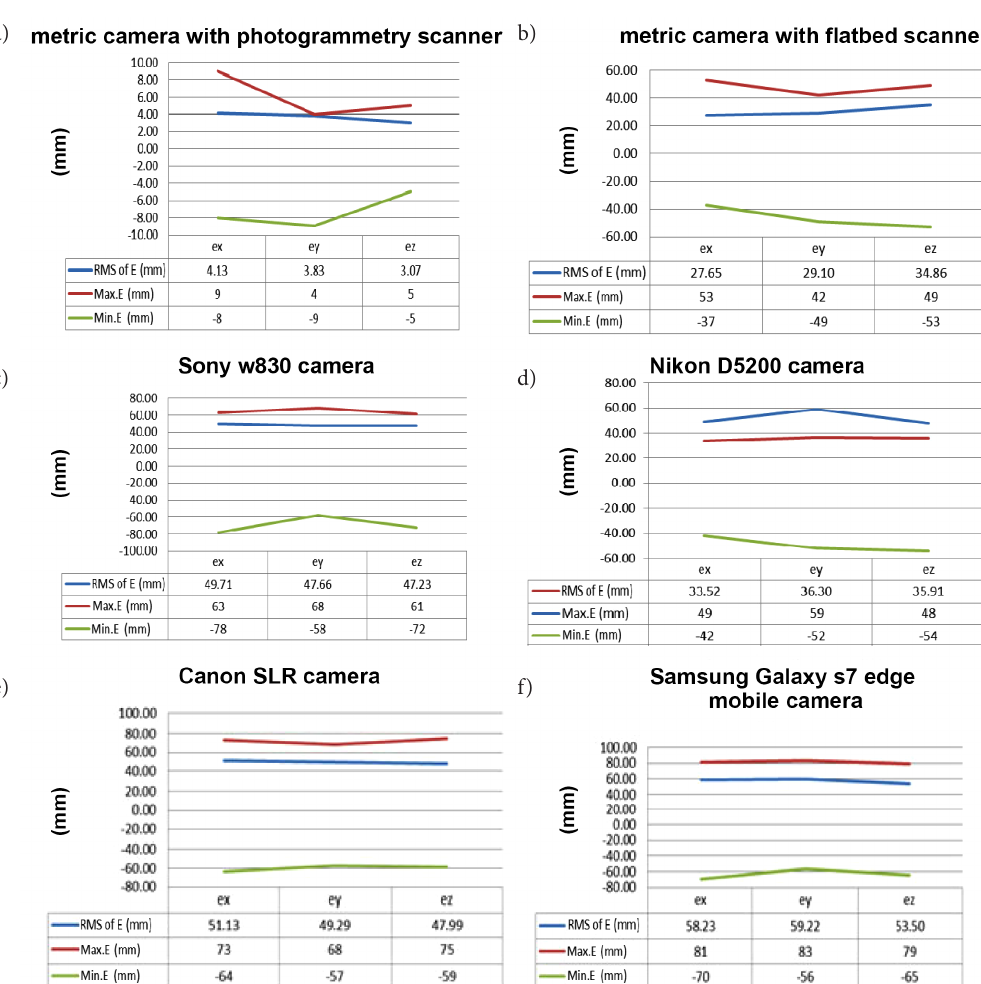
Figure 11. The results of RMSE, maximum and minimum differences between the coordinates of check points resulted from total station and imaging processing from metric camera with flatbed scanner and non-metric